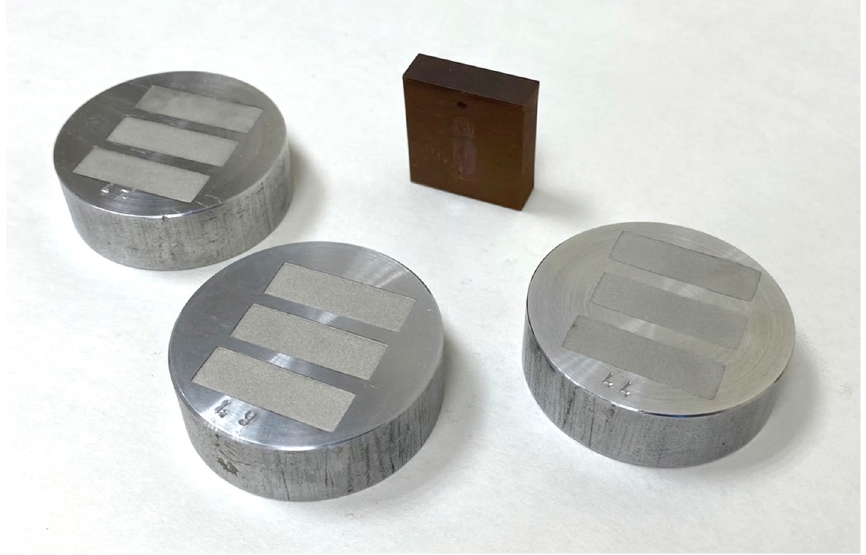
Figure 10. ADAM electrode and eroded aluminum workpieces. Table 12. Results of ADM copper electrode EDM test. Design Variables (Process